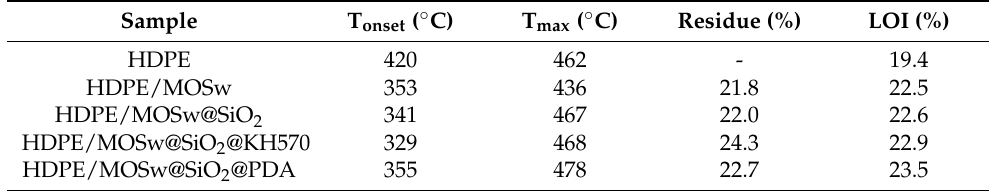
Table 3. LOI and parameters of thermal stability for neat HDPE, HDPE/MOSw, HDPE/